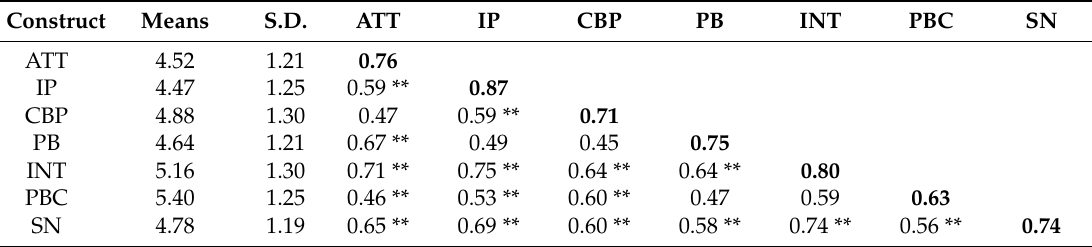
Table 4. Means, standard deviation, and